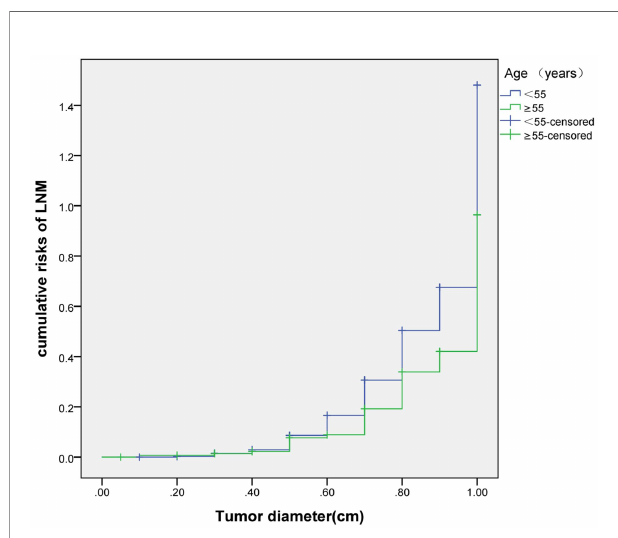
FIGURE 2 | Cumulative risks of LNM according to age and tumor